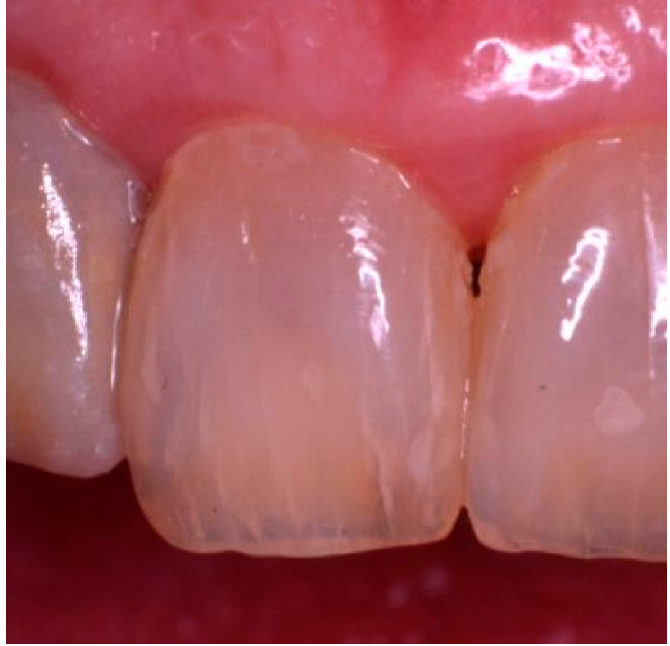
Figure 5. Example of translucent tooth image.